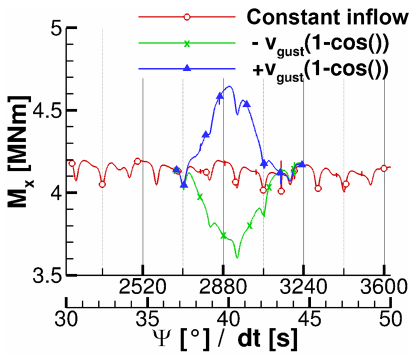
Figure 4. Rotor torque M x during the